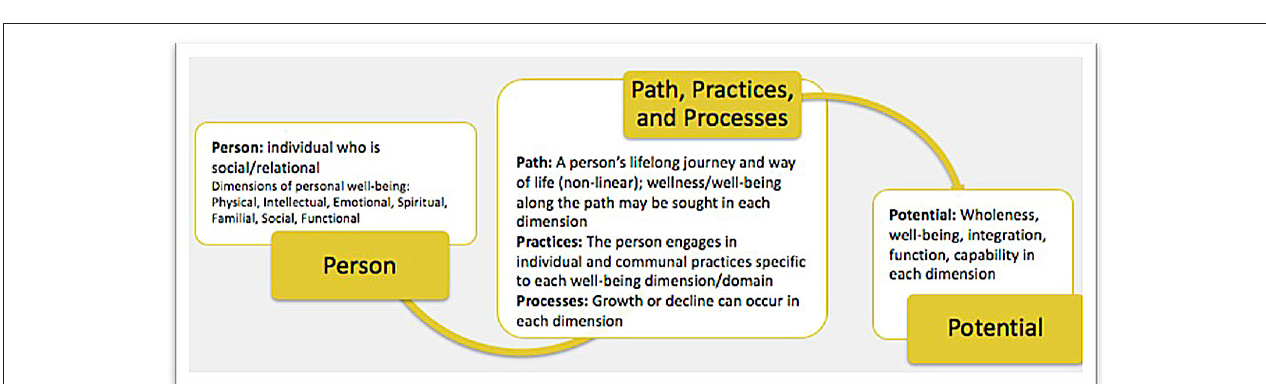
FIGURE 1 | Canadian model of occupational performance and engagement (CMOP-E).